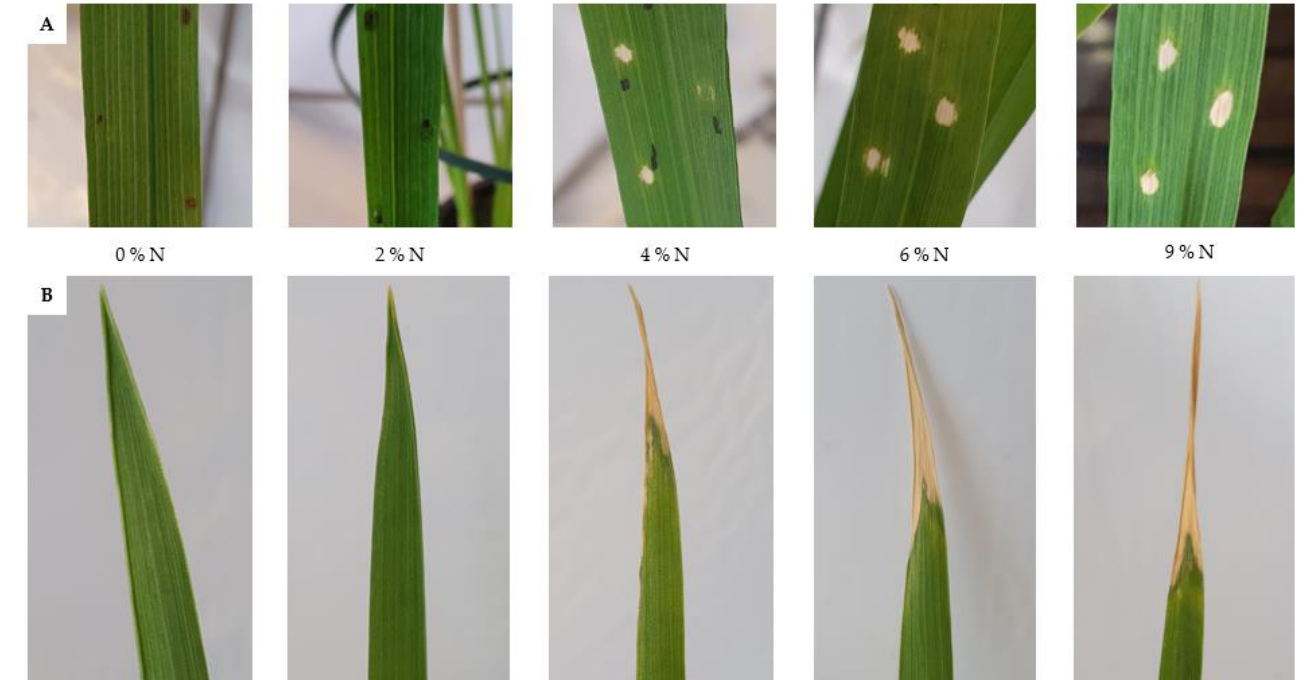
Figure 3. Nitrogen toxicity occurring 5 days after the application of urea solution with surfactant onto the YFEL of wheat (cv. Harenda). Three droplets of 3 µL urea solution with a concentration of 0, 2, 4, 6 or 9% N were pipetted onto the middle section of the adaxial surface of the YFEL. ( A ) Scorching underneath the droplets; and ( B ) scorching at the tip of the leaf.